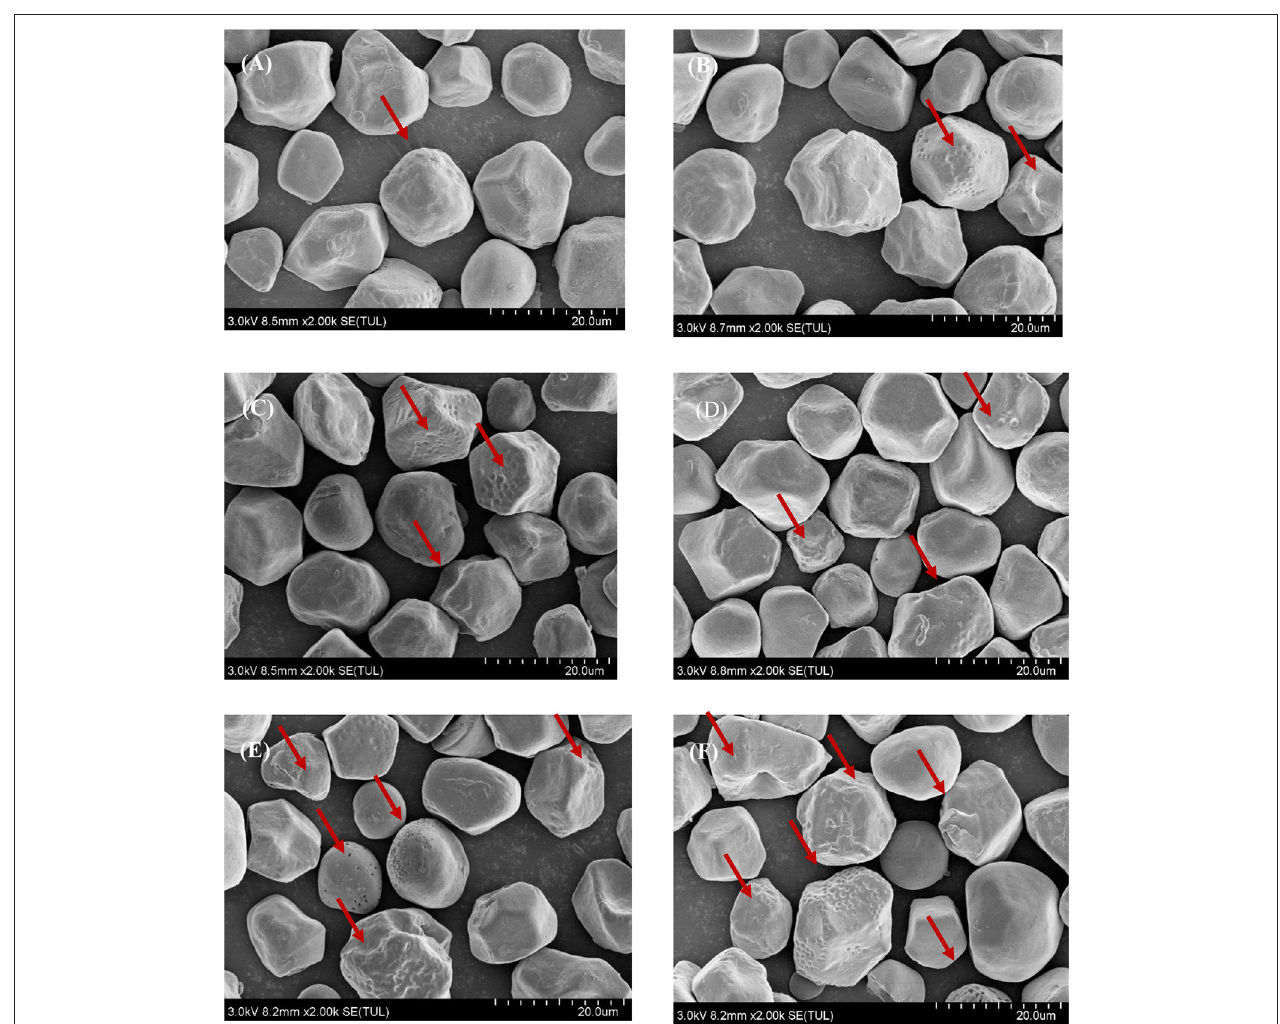
( Table 2 ). As fermentation progressed, the starch molecules were hydrolyzed into small molecules such as dextrin